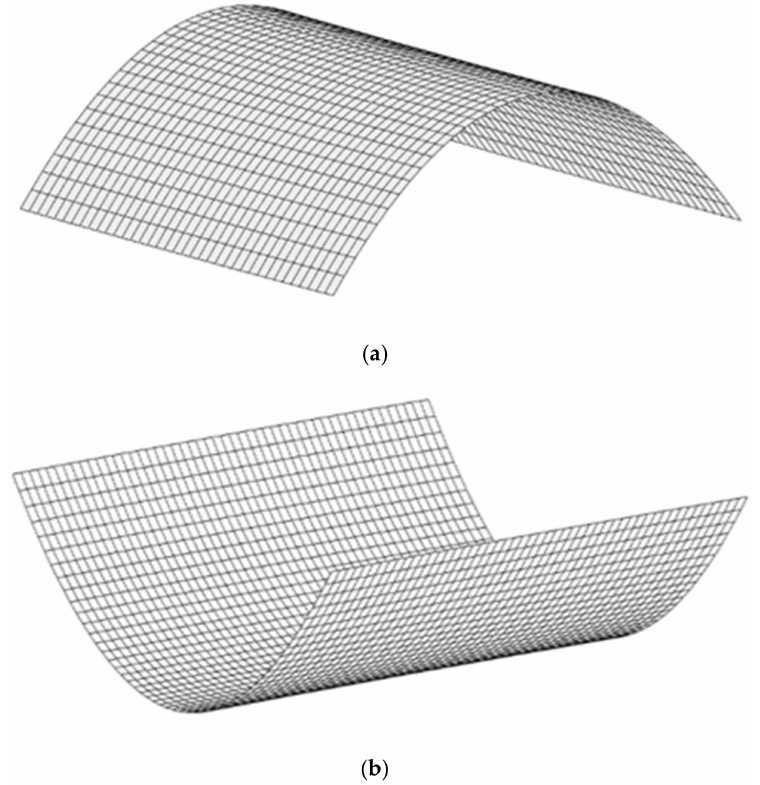
Figure 1. Two stable equilibria shapes of a cross-ply bistable composite plate, ( a ) the first stable ( b ) the second stable